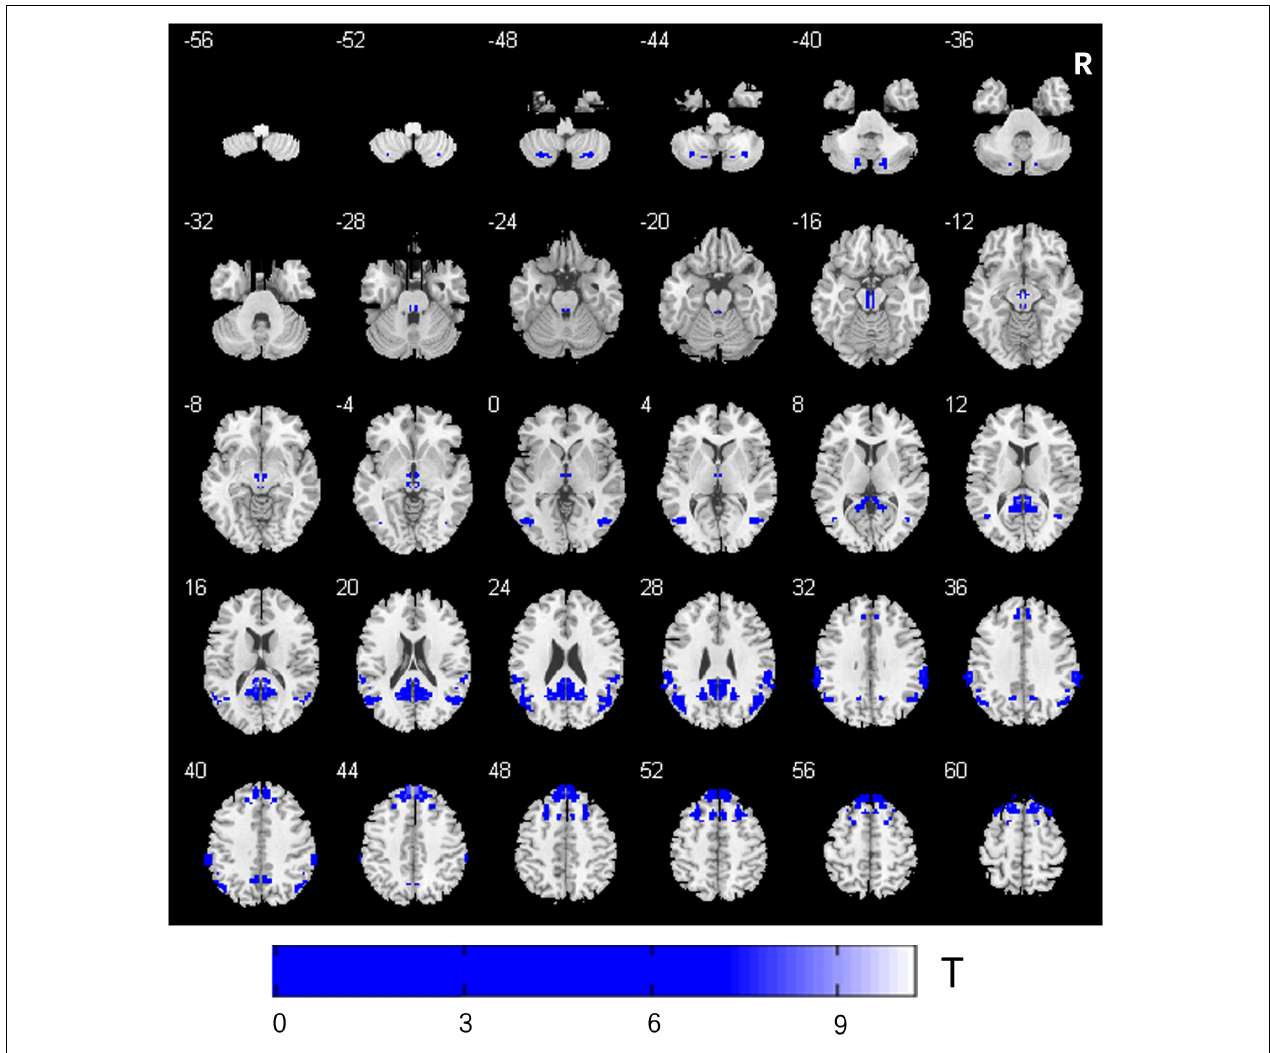
FIGURE 1 | Comparison of VMHC between the PD-Pre-DBS group and PD-Post-DBS group. PD, Parkinson’s disease; DBS, deep brain stimulation; PD-Pre-DBS, three days before DBS, PD-Post-DBS, one day after DBS; VMHC, voxel-mirrored homotopic connectivity; L, left; R, right; Regions showing decreased VMHC in blue; Family wise error correction (voxel p < 0.001, cluster p < 0.05).